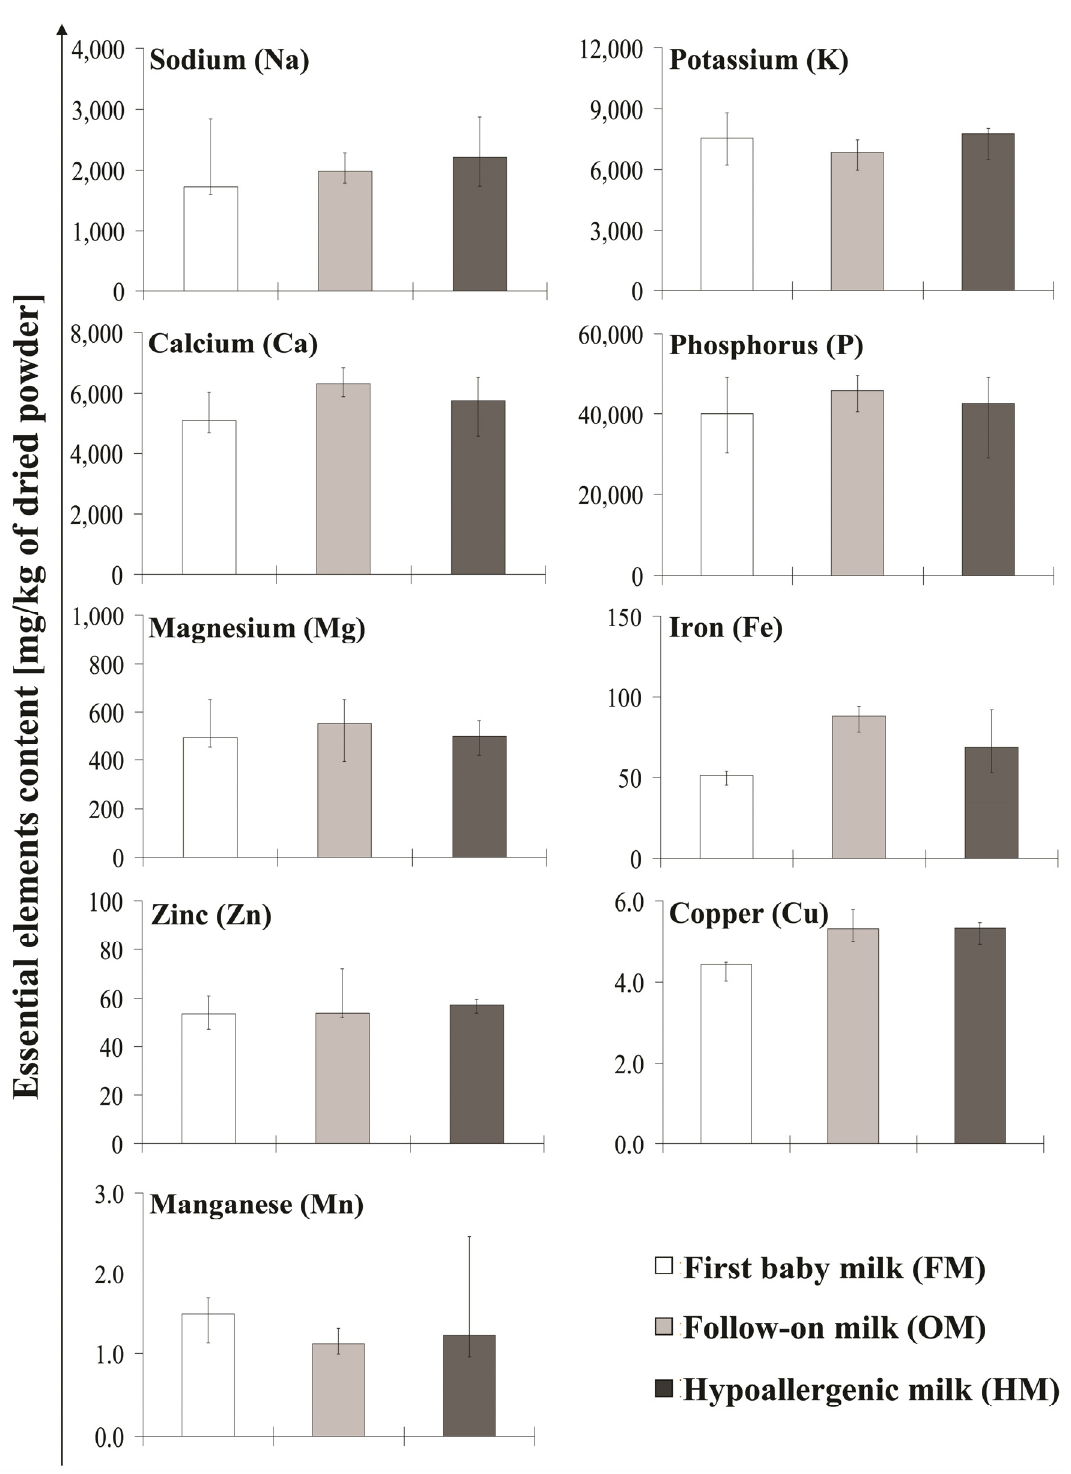
Figure 1. Concentration of the essential elements contained in analyzed baby milk. The values of sodium (Na), potassium (K), calcium (Ca), phosphorus (P), magnesium (Mg), iron (Fe), zinc (Zn), copper (Cu), and manganese (Mn) content in analyzed first baby milk (FM), follow-on milk (OM), and hypoallergenic milk (HM). The data are presented as median (interquartile range) values of six determinations.